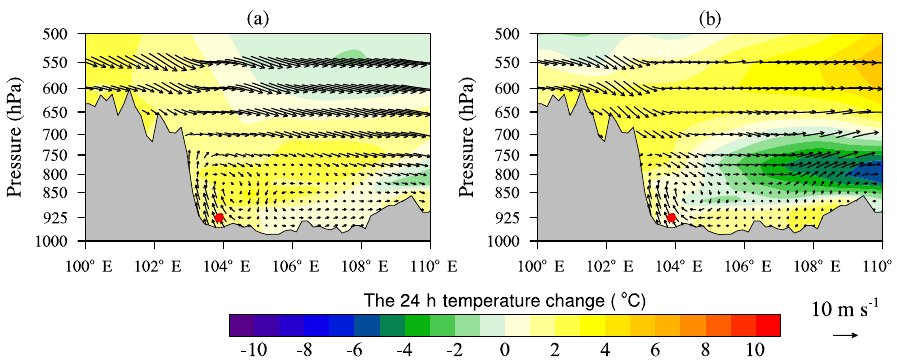
Figure 9. West–east vertical cross-sections of 24h temperature change (shading, units: ◦ C) and wind vectors (synthesized by u and w ) through the most polluted area (30.75 ◦ N) during the periods of improving air quality (a) for event 6 and (b) for event 7. Note that the vertical velocity is multiplied by 100 when plotting the wind vectors. The most polluted area is marked by red solid dots. The gray shading represents the terrain.